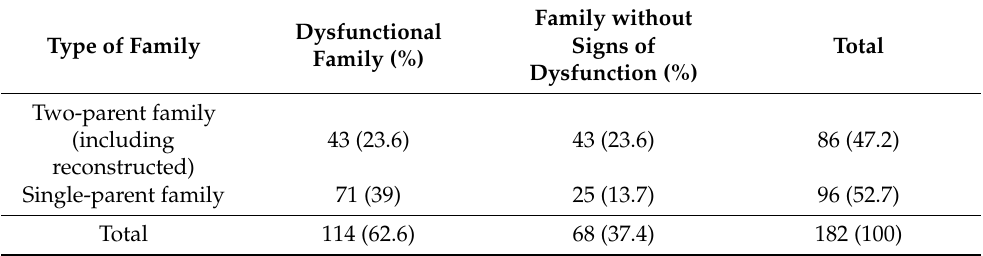
Table 1. Family background of juvenile offenders located in correctional